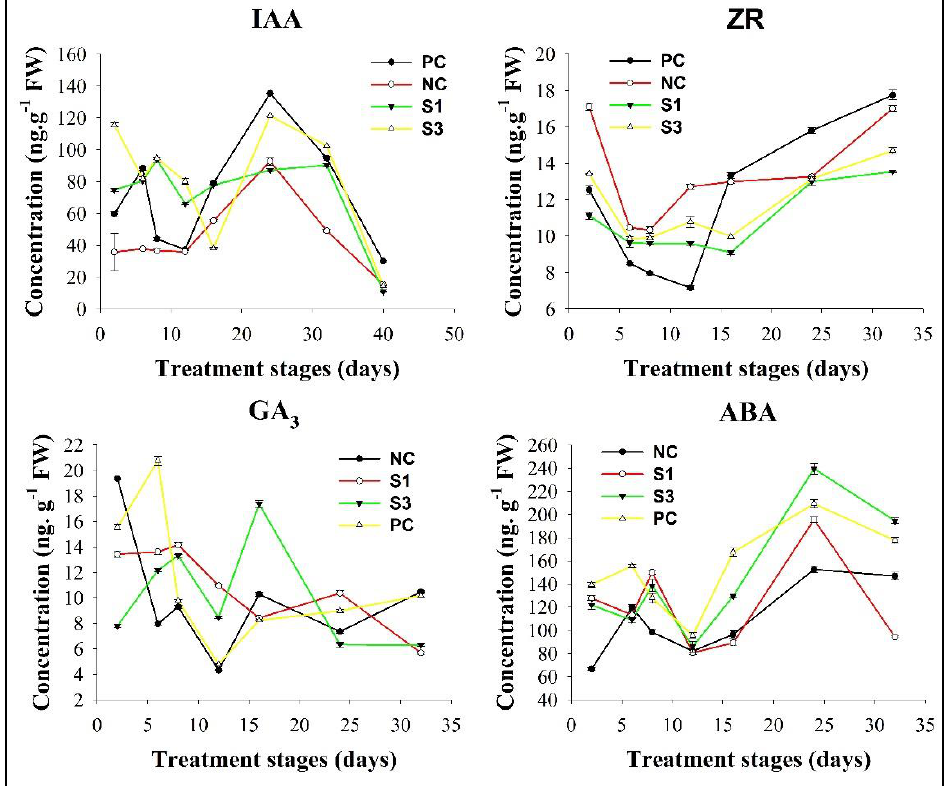
Figure 1. Fluctuation patterns of endogenous hormones in differently treated shoot samples. These curves were drawn according to the mean value of endogenous hormone concentrations in three biological replicates and error bars represented ±